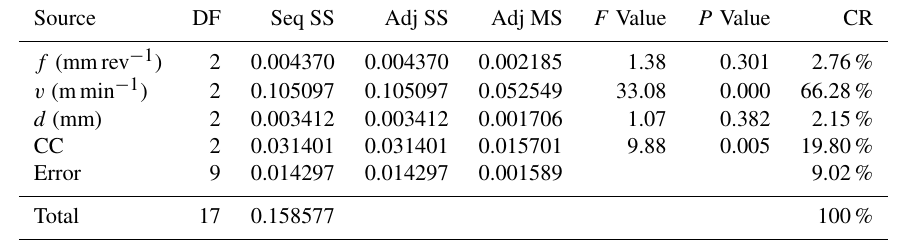
Table 7. ANOVA for SCE.